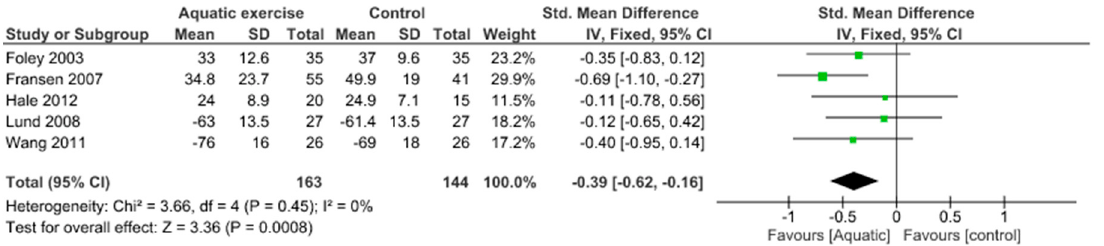
Figure 7. Function: Aquatic exercise versus Land-based exercise.